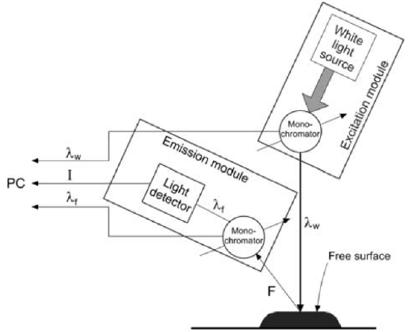
Figure 5. Scheme of surface fluorescence measurement. Source: [30,31].